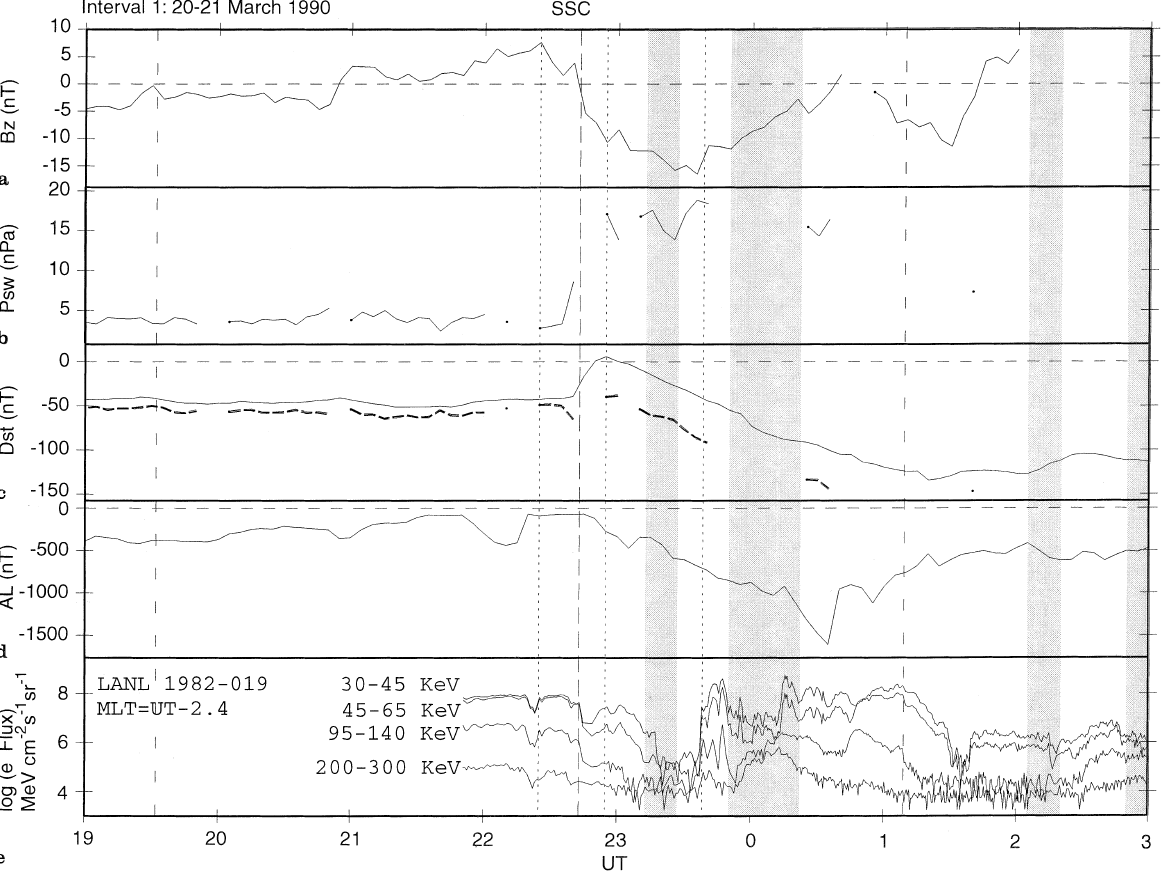
Fig. 2a–e. Time series plot presenting 5 min avearages of a the IMF-B and b solar wind plasma pressure at the subsolar magnetopause, P Dst ( solid line ) and Dst * ( broken line ), and d the AL magnetic index for interval 1 1990 UT to 0300 UT, March 20–21. e Low energy electron flux measured by the LANL 1984–129 spacecraft. The vertical lines